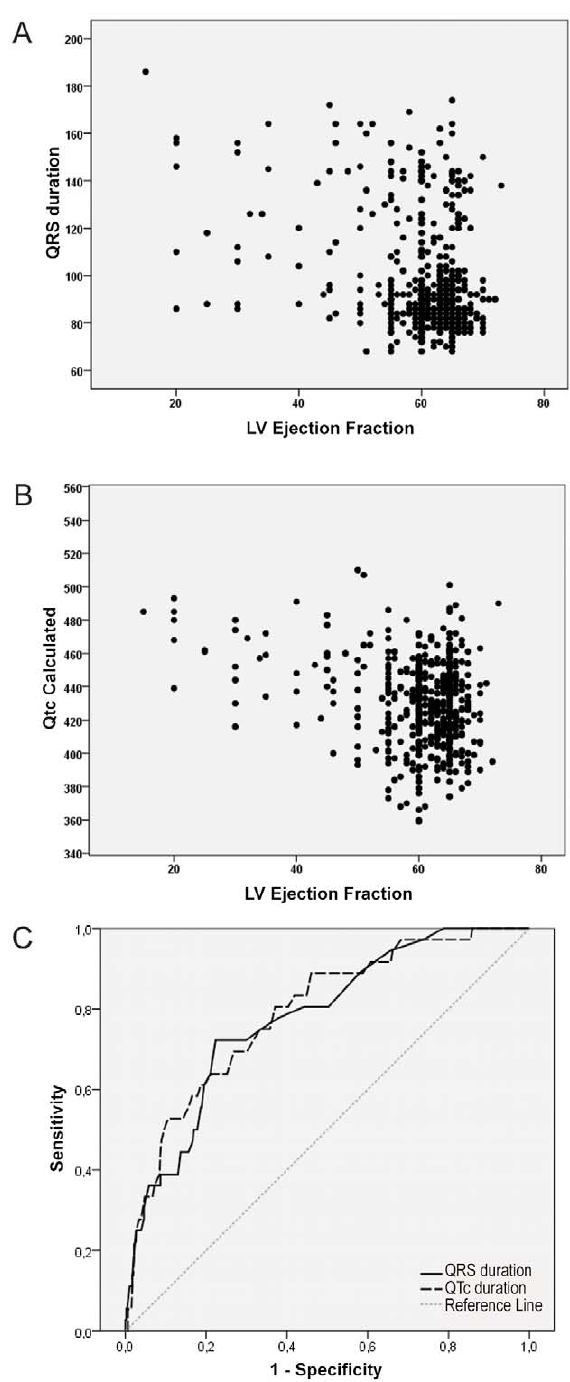
Figure 2. Association between by left ventricular ejection fraction and ECG measurements. A – Left ventricular ejection fraction and QRS duration; B - Left ventricular ejection franction and QT corrected interval; and C: Diagnostic accuracy (area under the ROC curve) of QRS duration and QT corrected interval in the detection of reduced left ventricular ejection fraction.